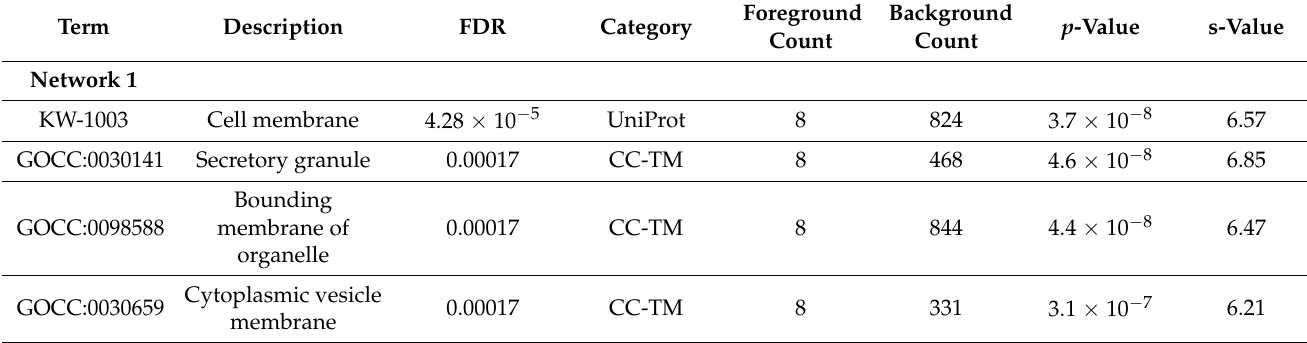
Figure 2. Protein network analyses identified by MCODE. The protein interaction network analysis was based on the 276 differentially expressed proteins identified by the comparison of patients with high and low viability after 48 h of in vitro AML cell culture. The figure presents the three clusters that included at least five proteins. Purple color indicates decreased abundance in the high viability group (i.e., high levels for patients with <25% viable cells due to increased spontaneous/stress-induced apoptosis); turquoise color indicates increased protein abundance in the high viability group. Table 3. Classification of proteins showing differential expression for each of the three networks identified in the protein network interaction analysis (see Figure 2) using a GO tool. We identified 276 proteins with significantly different levels, and 18 of them were included in the three networks. The table presents the six terms with the lowest false discovery rate (FDR) when analyzing GO cellular component/cellular component text mining, GO biological process, GO cell components, GO molecular function, KEGG pathways, Reactome pathways, and UniProt keywords. The table presents the description of each term together with foreground and background counts, as well as p - and s-values. S-value is a combination of (minus log) p value and effect size (i.e., positive associations in the foreground divided by all associations); a positive value indicates overrepresentation of a given term, and a negative value indicates underrepresentation of a given term. Foreground counts indicate the number of positive associations in a given cluster for a given term (i.e., the number of proteins associated with the given term) and background counts indicate the number of positive associations in the dataset. The proteins were ranked based on the FDR and the table presents the six highest ranked terms for each